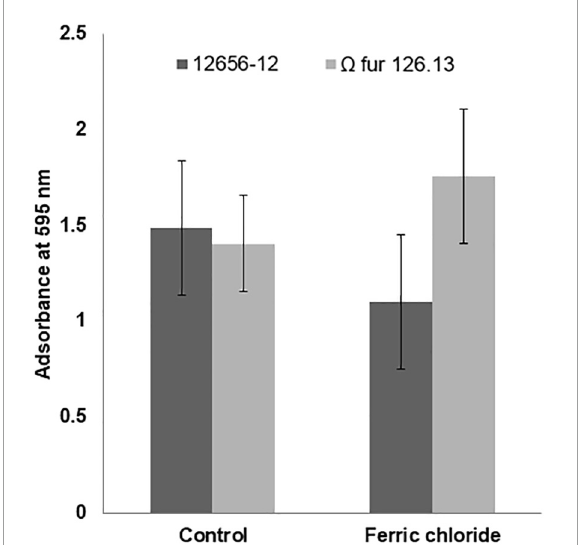
FIGURE8 G. anatis 12656-12 and (cid:127) fur 126.3 strains biofilm production in 24-h cultures supplemented or not with FeCl 3